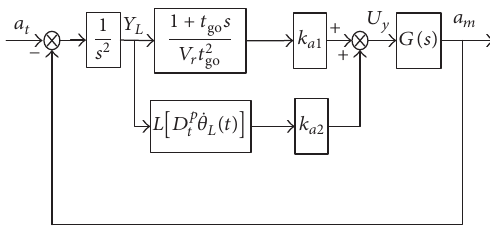
Figure 3: Illustration of the closed loop EPN guidance